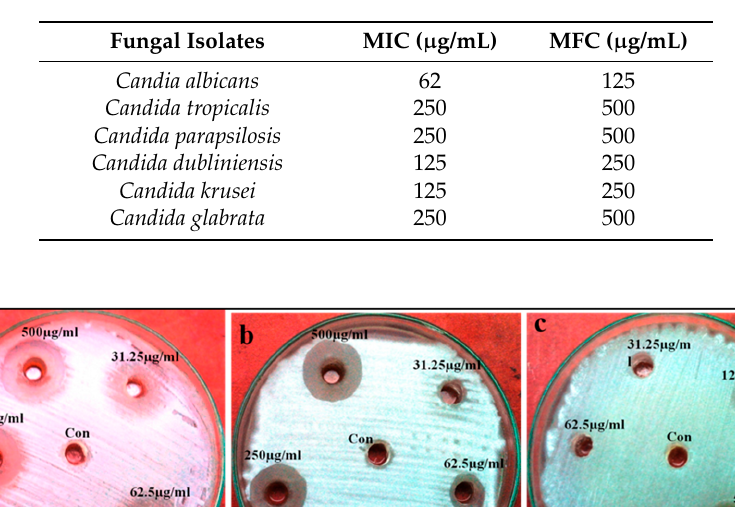
Table 2. MIC and MFC values of biosynthesized AgNPs against Candida strains .